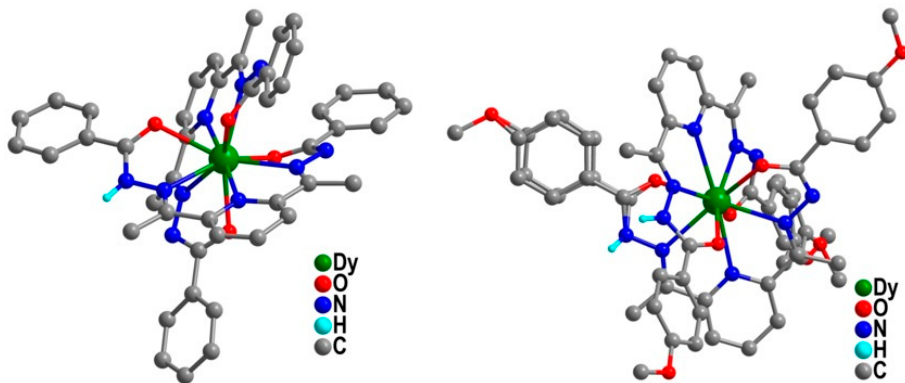
Figure 6. Molecular structure of 3 ( left ) and 6 (the two H’s at N are disordered with 50% occupancy: ( right ). The structures are re-drawn from Reference [40] with permission from MDPI.